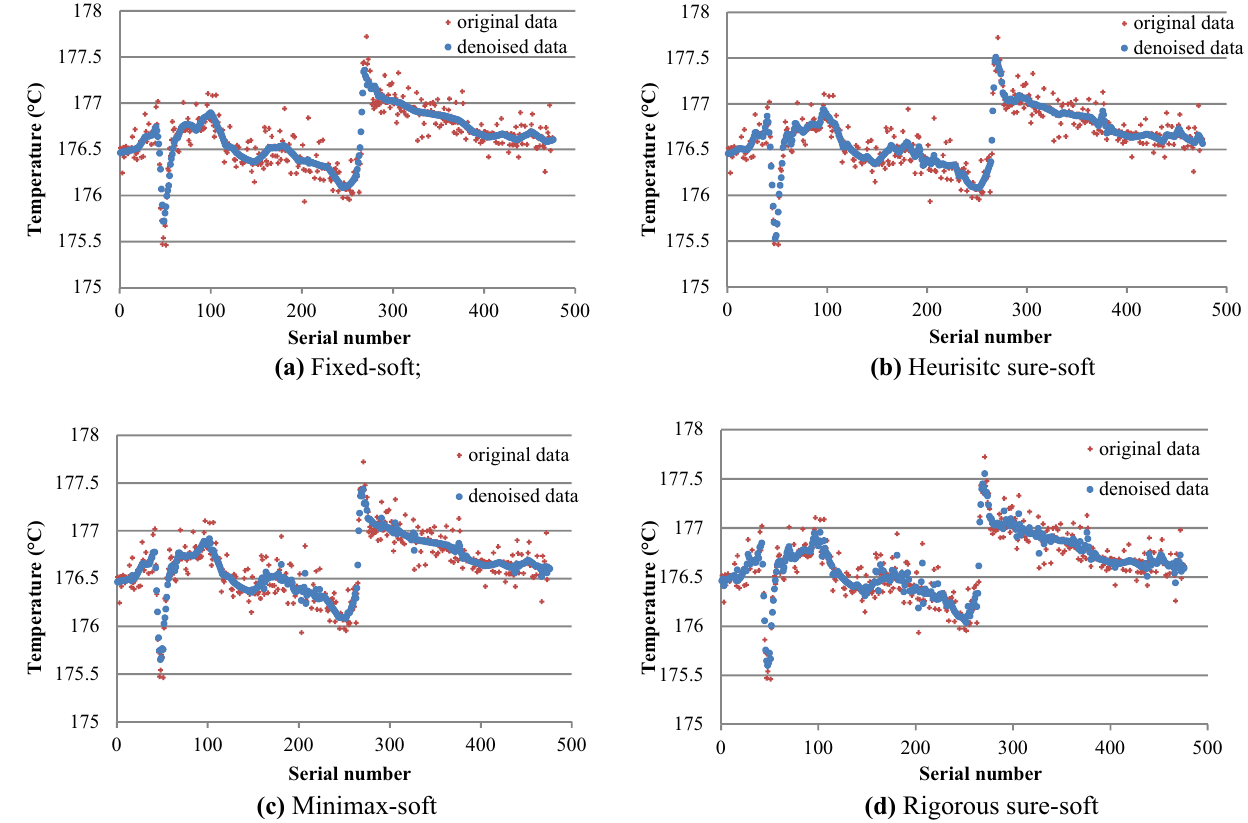
Fig. 10 Wavelet denoising results of temperature data with different threshold criteria a fixed soft; b Heuristic sure-soft; c minimax soft; d rigor- ous